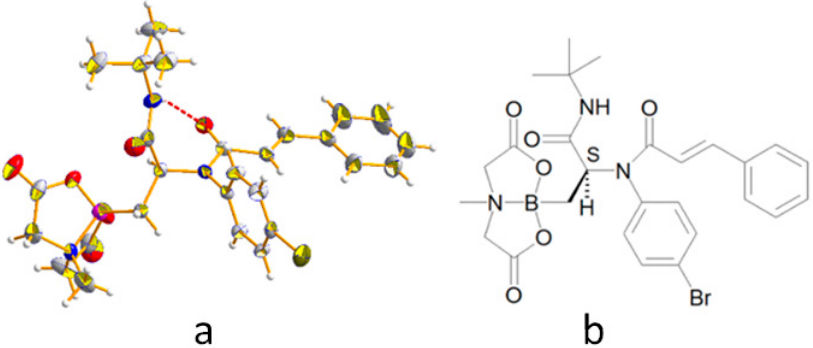
Figure 1. ( a ) Asymmetric unit of 5a . Thermal ellipsoids at RT were drawn at the 30% probability level (C: gray; H: white; O: red; N: blue; B: purple; Br: dark green). The only relevant NH–O intramolecular hydrogen bond is highlighted as a red dashed line. ( b ) Molecular structure of the S- 5a enantiomer (also the R enantiomer is present in the crystal in a 1:1 ratio) [26].